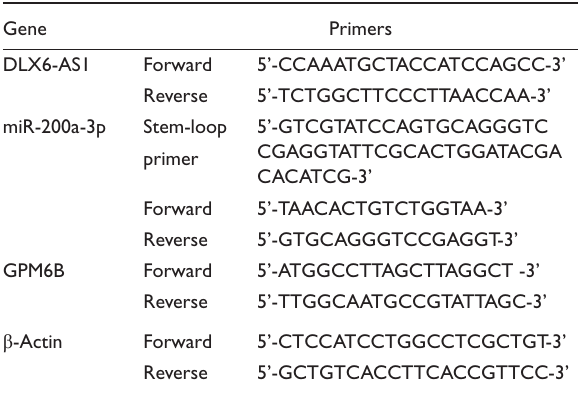
Table 2. Primers of qRT-PCR Gene Primers